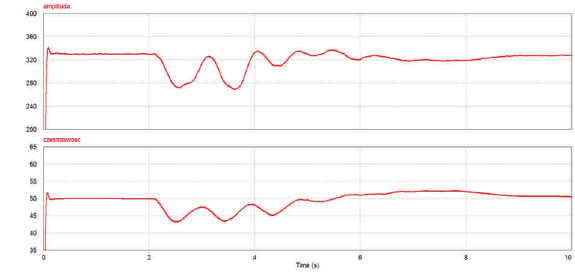
Fig. 7. Changes in generator current parameters with load increase: 30-110